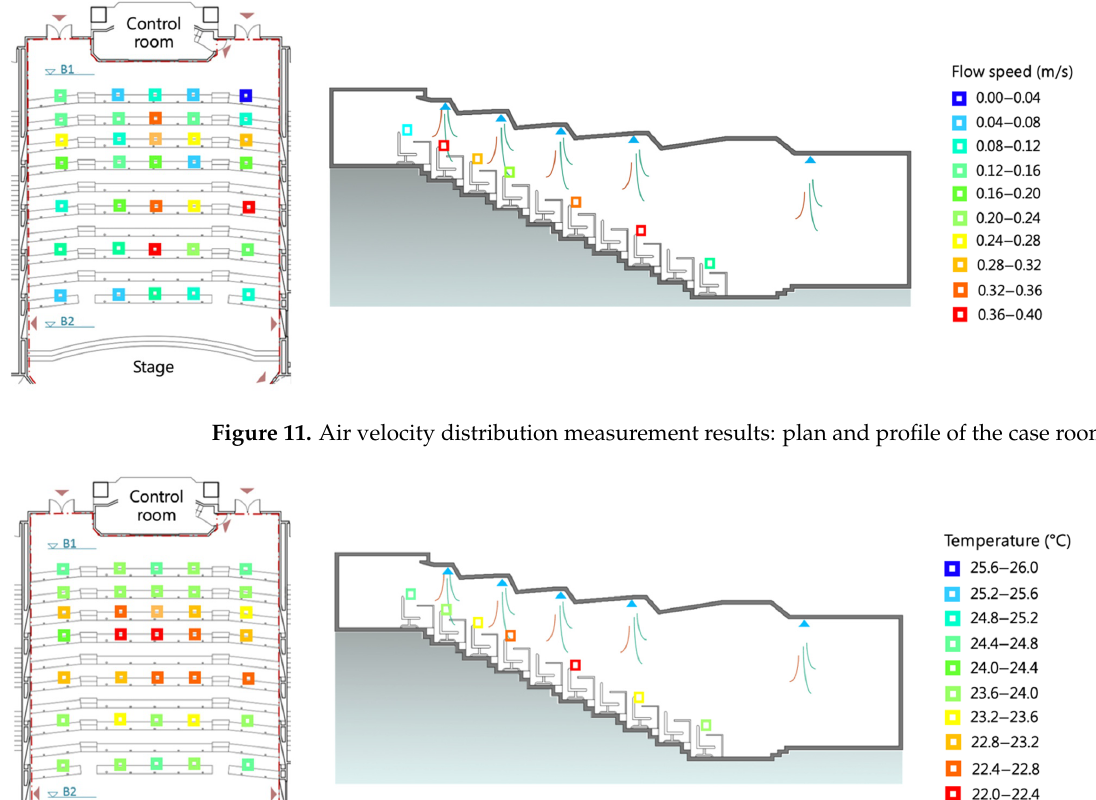
( b ) Figure 13. Simulation results of velocity in ( a ) simplified diffuser model and ( b ) detailed diffuser model.